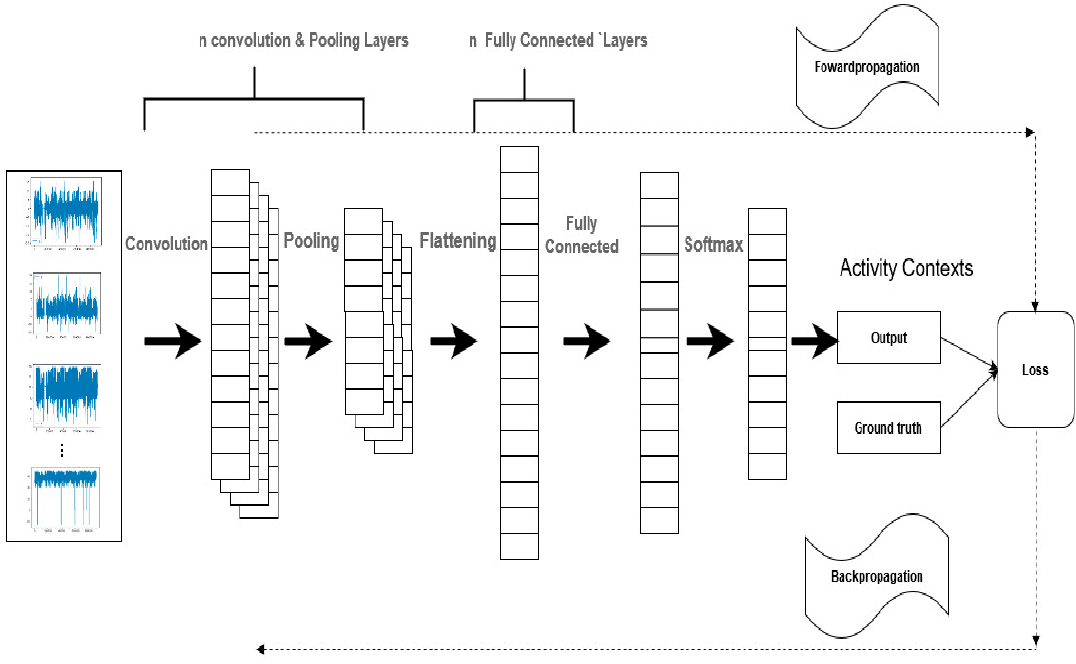
Figure 9. Architecture of the proposed system.